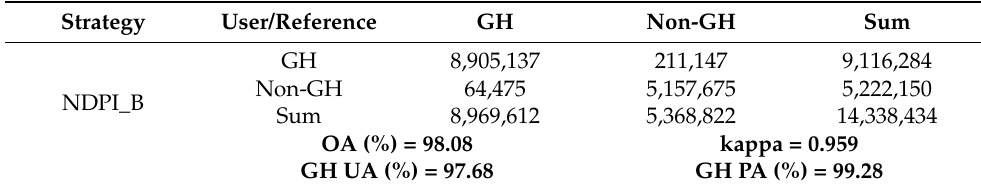
Table 6. Pixel-based confusion matrices from ground truth (TTA Mask) for the DT based on the NDPI_B Figure 7. Reflectance values of the SWIR bands of the WV3 image for four PCGs with different colors. The four orange vertical lines represent the central wavelengths of SWIR10, SWIR12, SWIR13 and SWIR16.